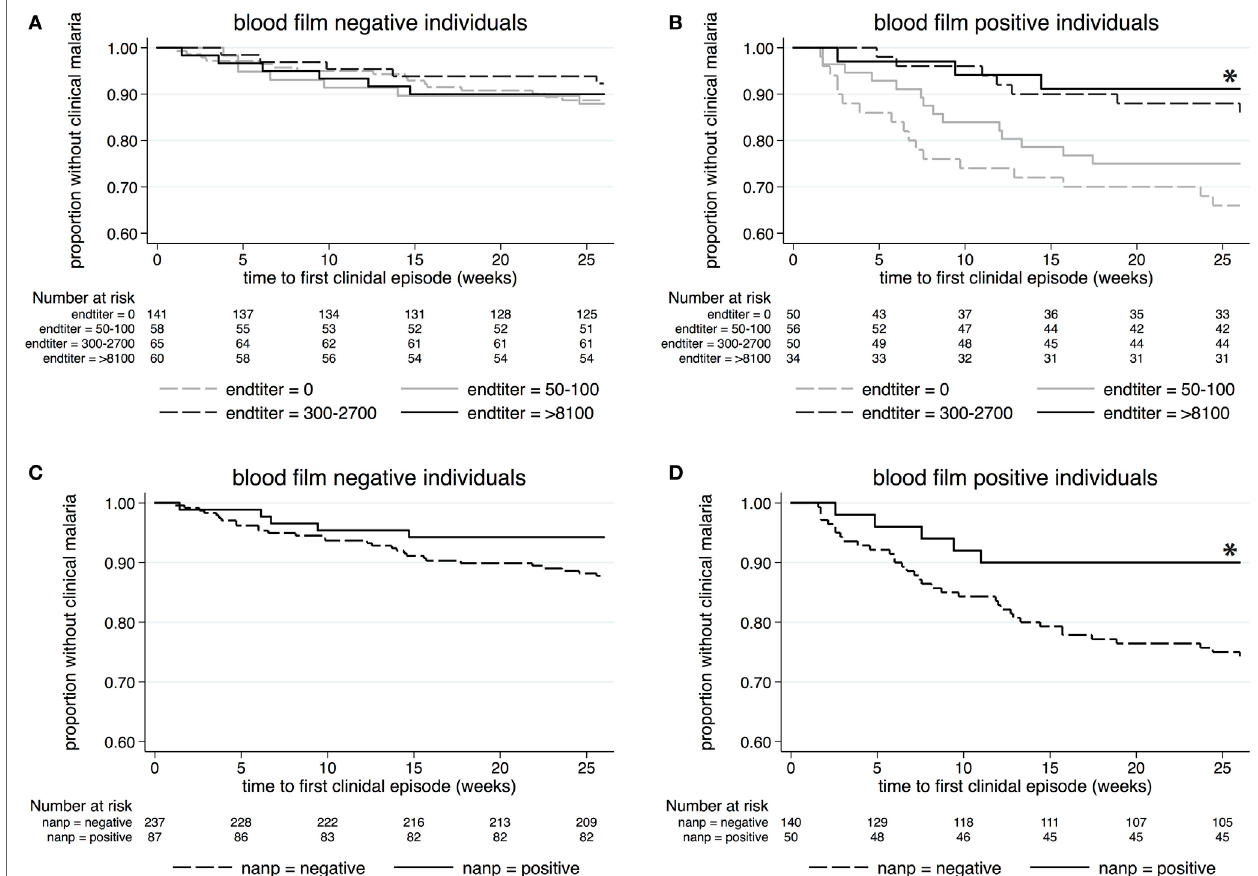
FigUre 3 | Kaplan–Meier analysis of time to clinical malaria during the 26-week follow-up . Survival curves display the proportion of malaria-free individuals over time, stratified by anti- Pf spz antibody titer (a,B) or (NANP) 5 -seropositivity status (c,D) . (a) Among blood film-negative individuals, serum levels of anti- Pf spz antibodies did not have an impact on the incidence of clinical malaria (log-rank Mantel–Cox test: χ 2 = 0.81; p = 0.847). (B) High anti- Pf spz antibody titers were significantly associated with a reduced risk of and increased time to first clinical episode among blood film-positive individuals (log-rank Mantel–Cox test: χ 2 = 10.65; p = 0.014). (c) Anti-(NANP) 5 seropositivity did not correlate with malaria incidence among blood film-negative individuals (log-rank Mantel–Cox test: χ 2 = 2.74; p = 0.098). (D) Anti-(NANP) 5 seropositivity was significantly associated with reduced malaria incidence among blood film-positive individuals (log-rank Mantel–Cox test: χ 2 = 5.02; p =